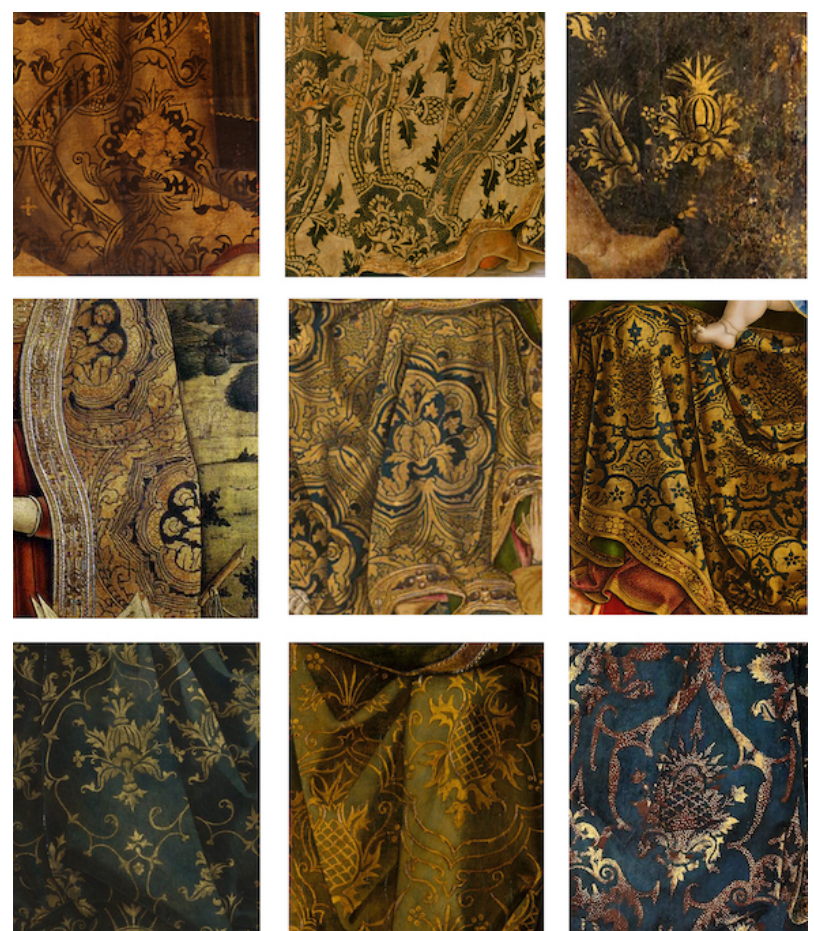
Figure 10. Angelos Bitzamanos. Saint Francis (detail from the Scottivoli altarpiece), 1508. Vatican, Apostolic Palace ( left ) © Musei Vaticani. Reproduced with permission; Nicola di Maestro Antonio d’Ancona. Saint Francis, 1472. Pittsburgh, Carnegie Museum of Art ( middle ) Image in the public domain; Nicola di Maestro Antonio d’Ancona. Saint Francis (detail from the polyptych of Jesi), 1487. Avignon ( right ) Image in the public domain; Figure created by author.